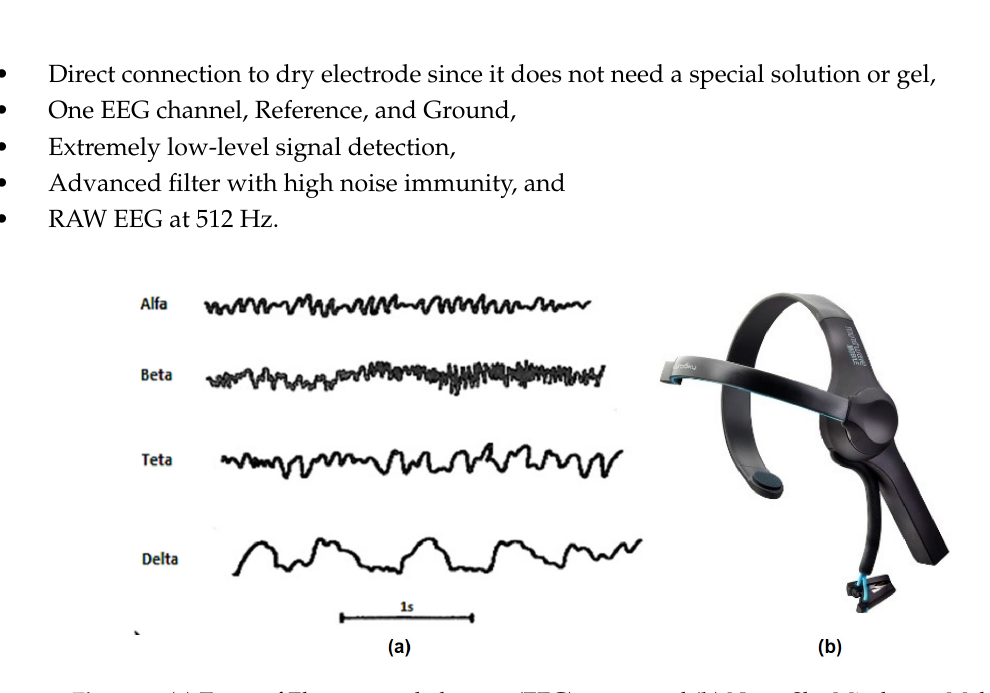
Figure 2. ( a ) Types of Electroencephalogram (EEG) waves and ( b ) NeuroSky Mindwave Mobile.